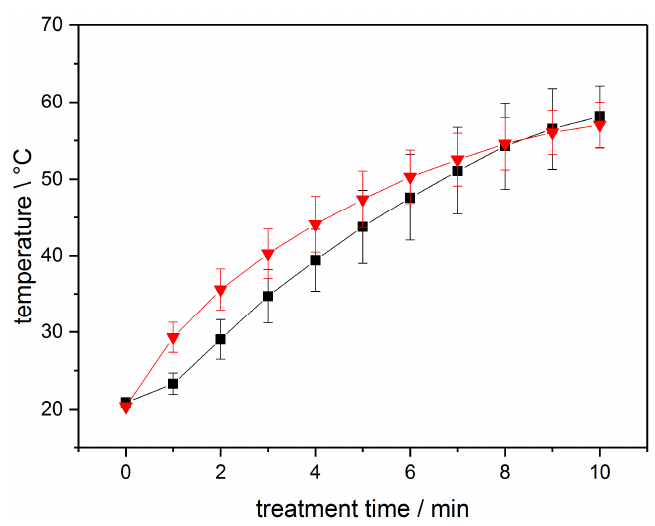
Figure 4. Temperature behaviour of 1 mL (red graph) and 3 mL (black graph) liquid during a plasma treatment using the setup displayed in Figure 1 (n = 3).